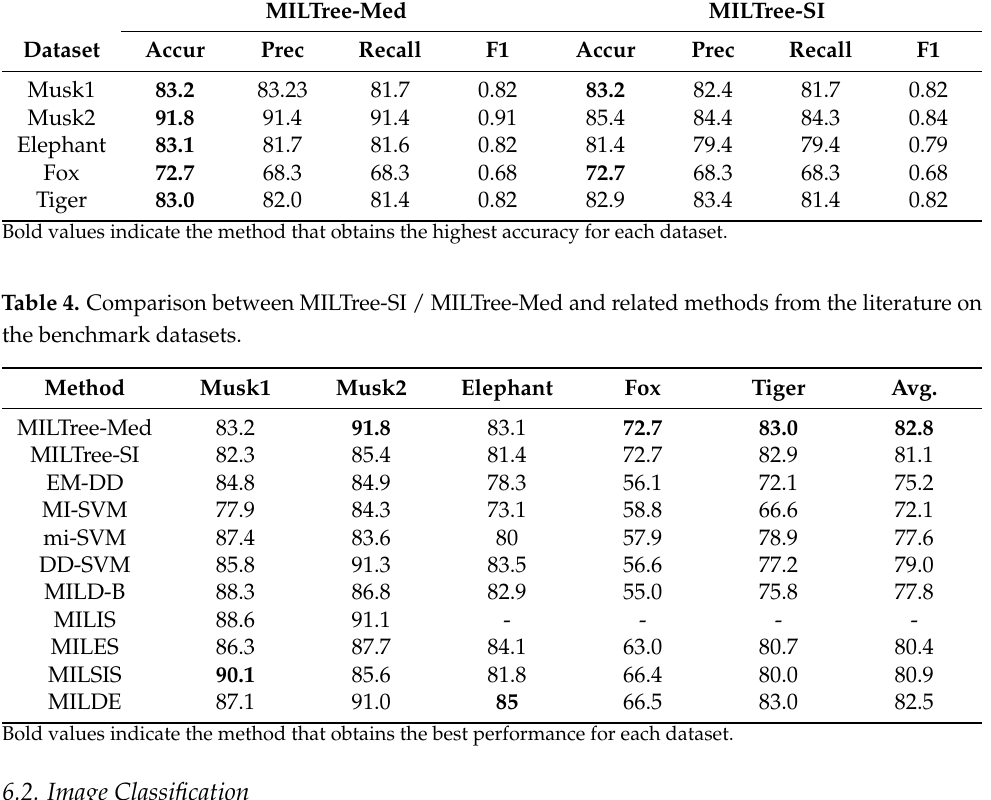
Table 3. Results of classification using MILTree-Med and MILTree-SI on the benchmark datasets.